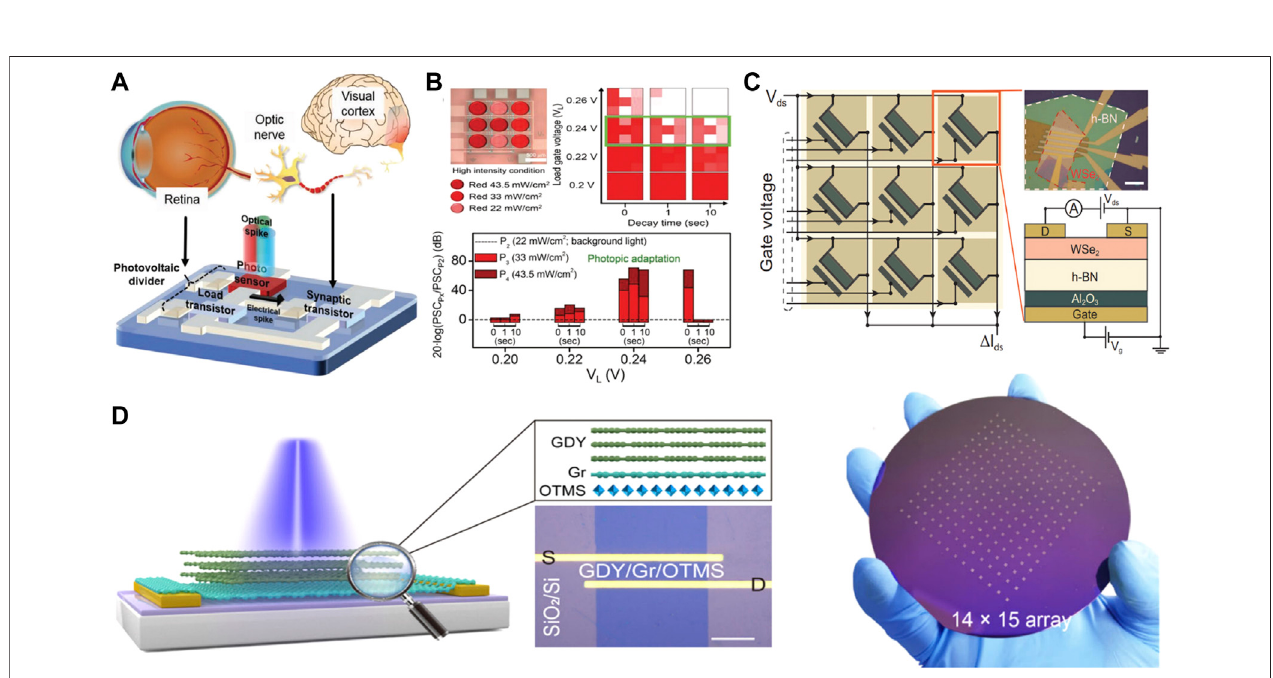
FIGURE 4 | (A) Schematic diagram of a light-tunable optoelectronic transistor-based bionic perceptual circuit consisting of a photovoltaic voltage divider and an ionic synaptic transistor. (B) Low-intensity (10.5 – 33 mW cm − 2 ) and red illuminance gradation, respectively. For the PSC decibel levels, P 1 – P 4 represent red-light intensitiesof10.5,22,33,and 43.5 mW cm − 2 ,respectively(adaptedfromKwon etal., 2019). (C) Schematic diagramofa3×3retinalmorphometricsensorwithWSe 2 /